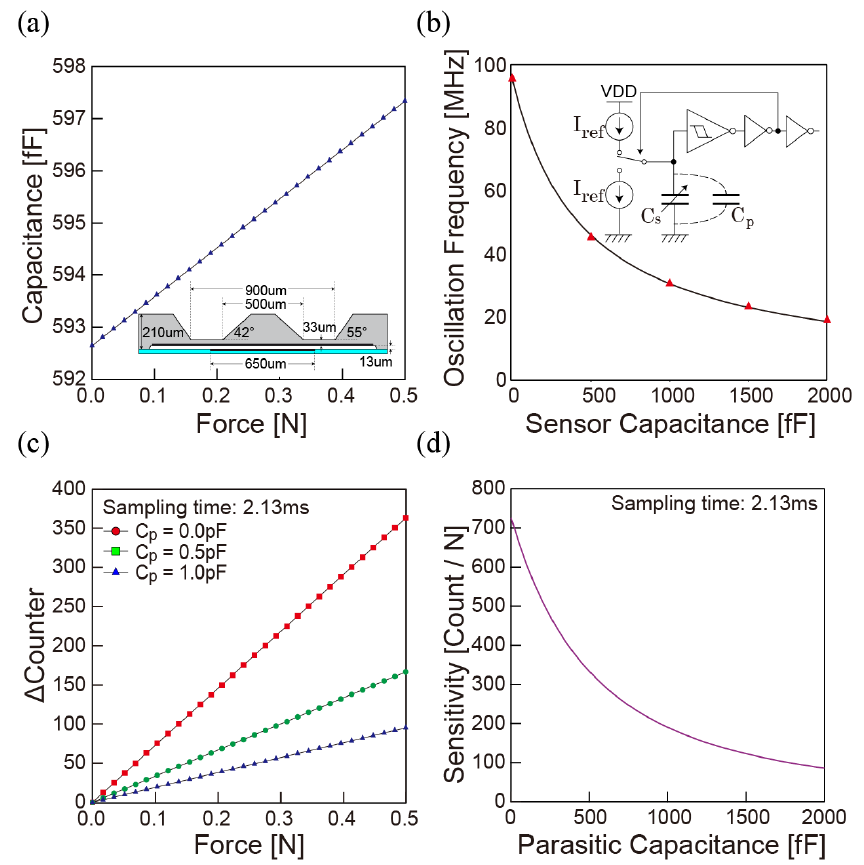
Figure 3. Mechanical and circuit simulation: ( a ) mechanical simulation of the force sensing element; ( b ) capacitor–frequency simulation extracted from the layout of Schmitt trigger oscillator in the ASIC; ( c ) calculated change of digital counter under an external force on a diaphragm; ( d ) influence of parasitic capacitance on